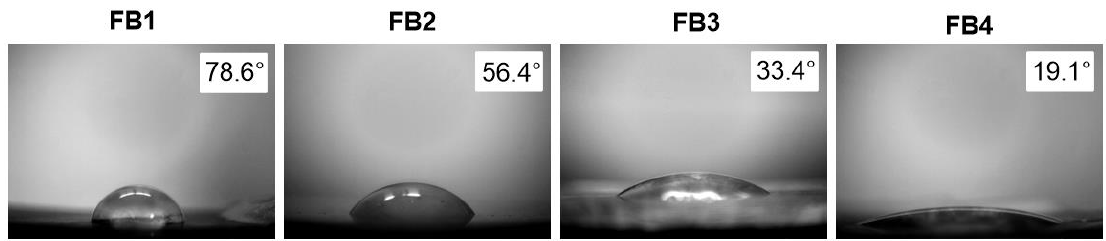
Figure 2. Contact angles of wetting for FB1 – FB4 .